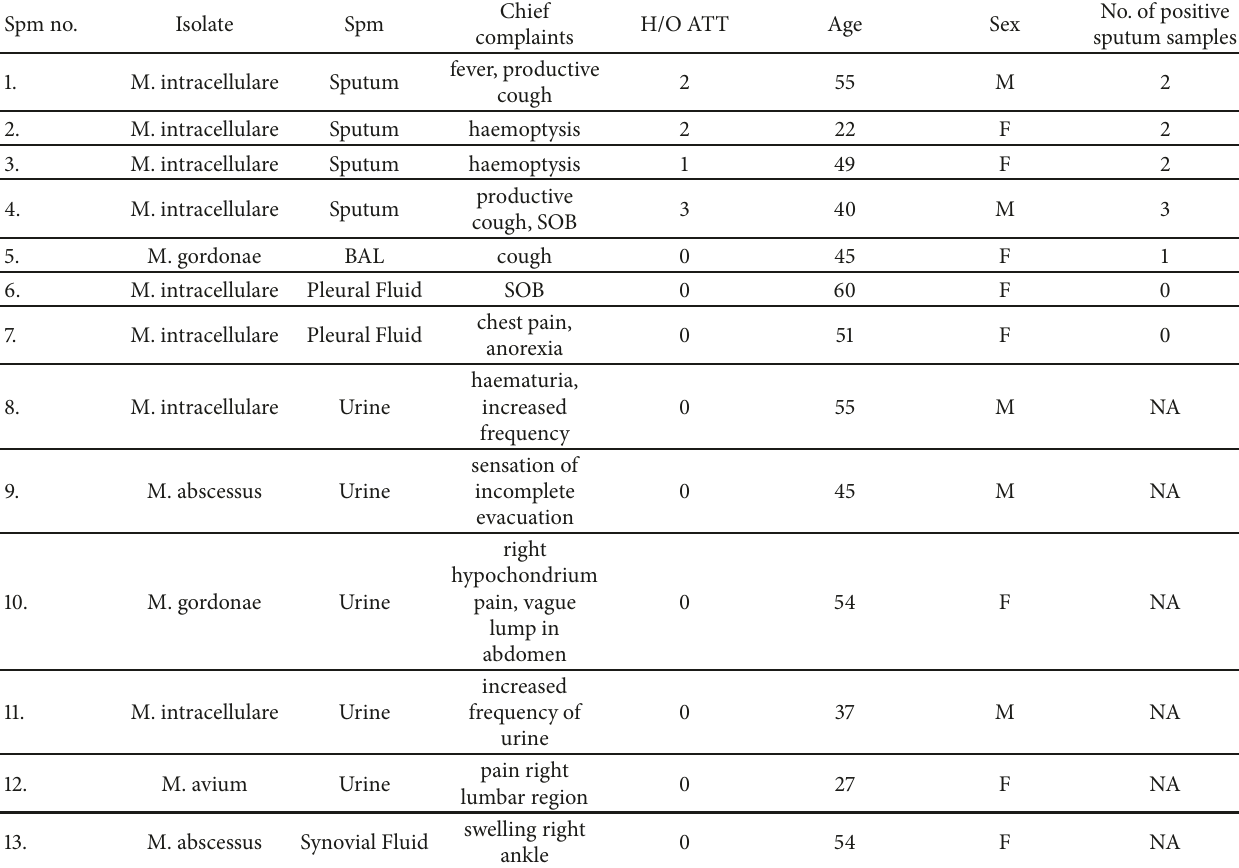
Table 1: Clinical and microbiological features of clinically significant NTM.